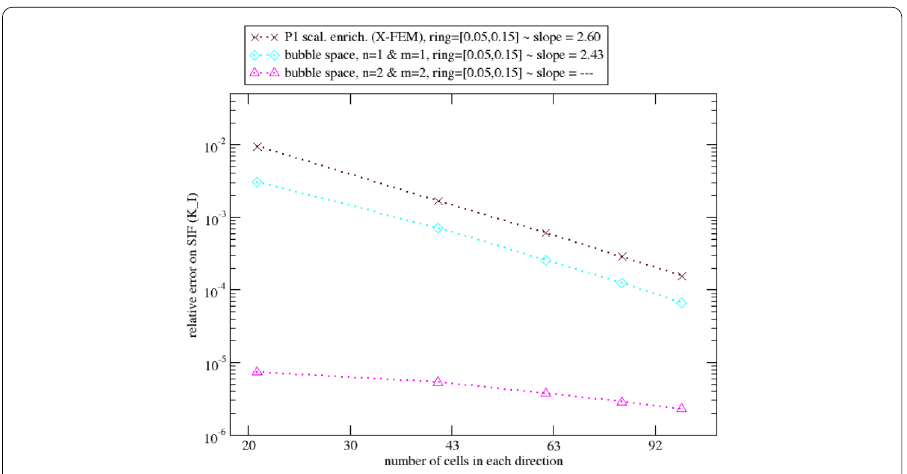
Fig. 36 Convergence analysis of stress intensity factor for the mode I problem. Stress Intensity Factors (SIF) are estimated with a domain integral method (G-theta method [42,43]). The “bubble” formulation with quadratic elements reaches the limit of numerical accuracy of the estimator used so that a convergence analysis cannot be performed here. For formulations with linear elements, the convergence rates are close to the optimal rate of convergence with mesh refinement, around